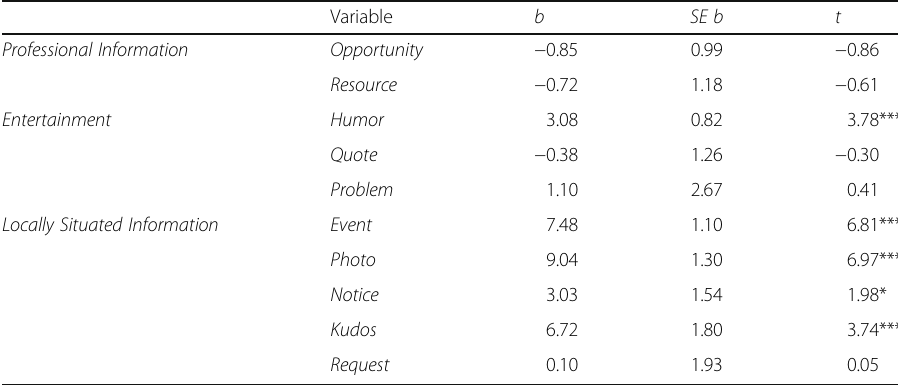
Table 2 Regression of the number of interactions by Post category Variable b SE b t Professional Information Opportunity − 0.85